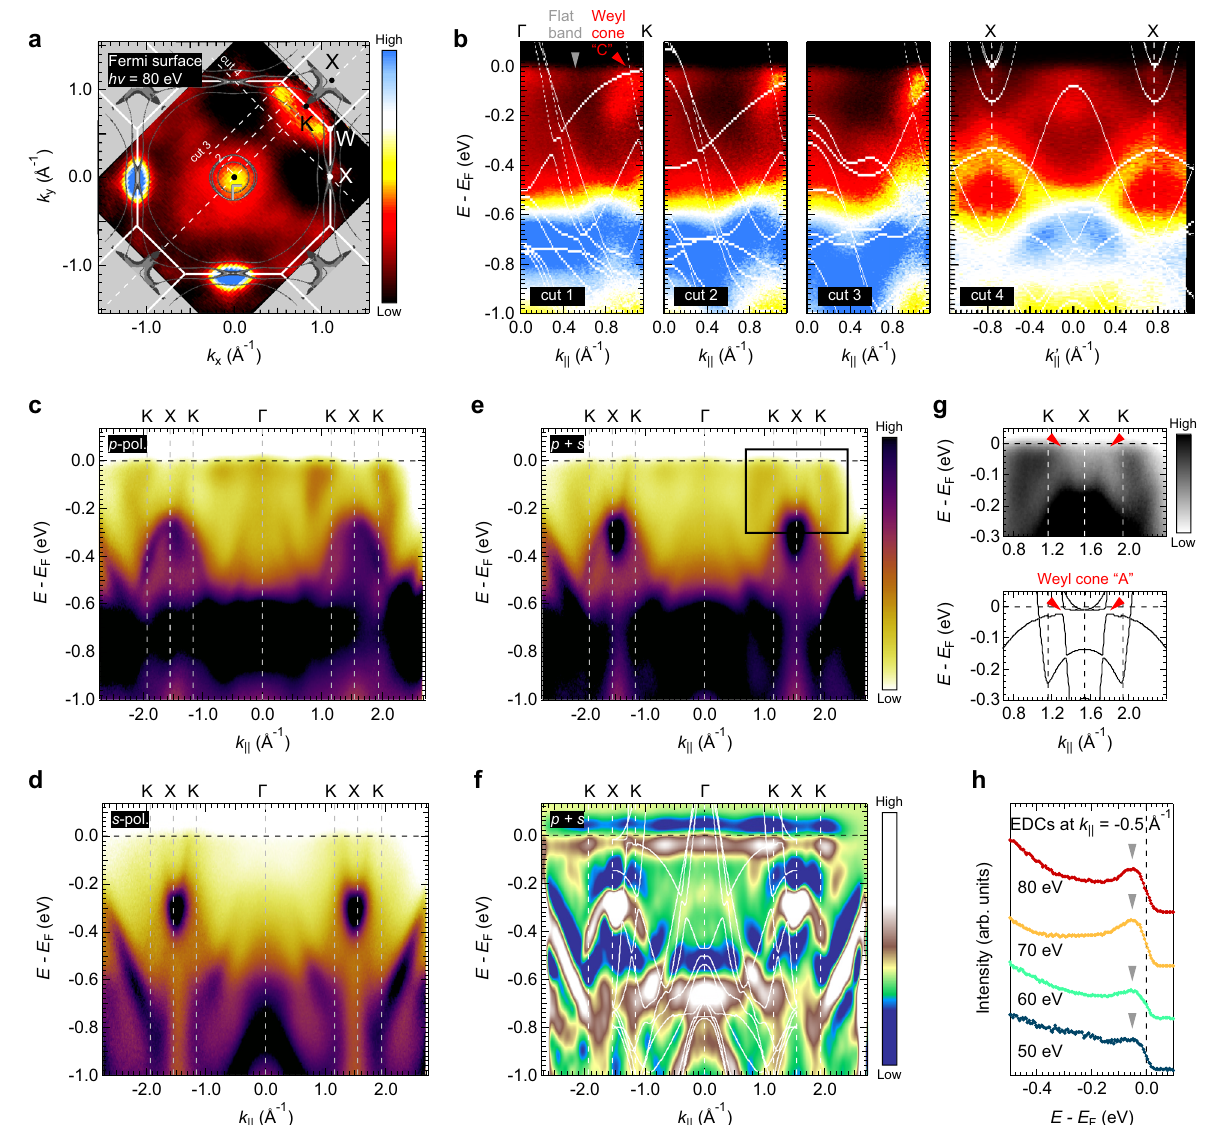
Fig. 3 Observed band structures of an electron-doped Co 2 MnGa fi lm. a Fermi surface of sample E2 ( N v = 28.5) obtained at 80 eV with p -polarized light. The calculated Fermi surface of the stoichiometric Co 2 MnGa ( N v = 28.0) with 70 meV chemical potential shifted is overlaid. b Observed and calculated band structures along cuts 1 – 4 marked by white dashed lines in a . c , d Wide ARPES images along the Γ – K – X line recorded at 80 eV with p - and s - polarizations, respectively. e ARPES image with p -polarized light c is added with that with s -polarized light d . f Second derivative ARPES image of e with respect to the energy and momentum directions. The calculated band dispersion is overlaid. g Magni fi ed ARPES image (upper) in the frame in e and corresponding calculation (lower). h Photon-energy-dependent EDCs at k ∣∣ = − 0.5 Å − 1 taken at 50, 60, 70, and 80 eV with p -polarized k = 2 π / a planes and yield a large Berry curvature at E = E z F (Fig. 2f), leading to a large anomalous Hall conductivity. The calculated σ A xy and α A xy qualitatively explain the experimental results (Fig. 1g, j). Speci fi cally, the electron-doped sample exhibits large anomalous transport properties. However, the simple E F shift that follows the rigid band model based on the stoichio- metric Co 2 MnGa gives a quantitative discrepancy with the N v dependence of σ A xy and α A xy obtained from experiments. For example, the calculated negative α A xy in the E − E F < 0 region is not observed in the experimentally hole-doped samples. This discrepancy may be caused by an extrinsic mechanism or the formation of anti-site defects arising from off-stoichiometric compositions, which is not taken into account in the calculations.